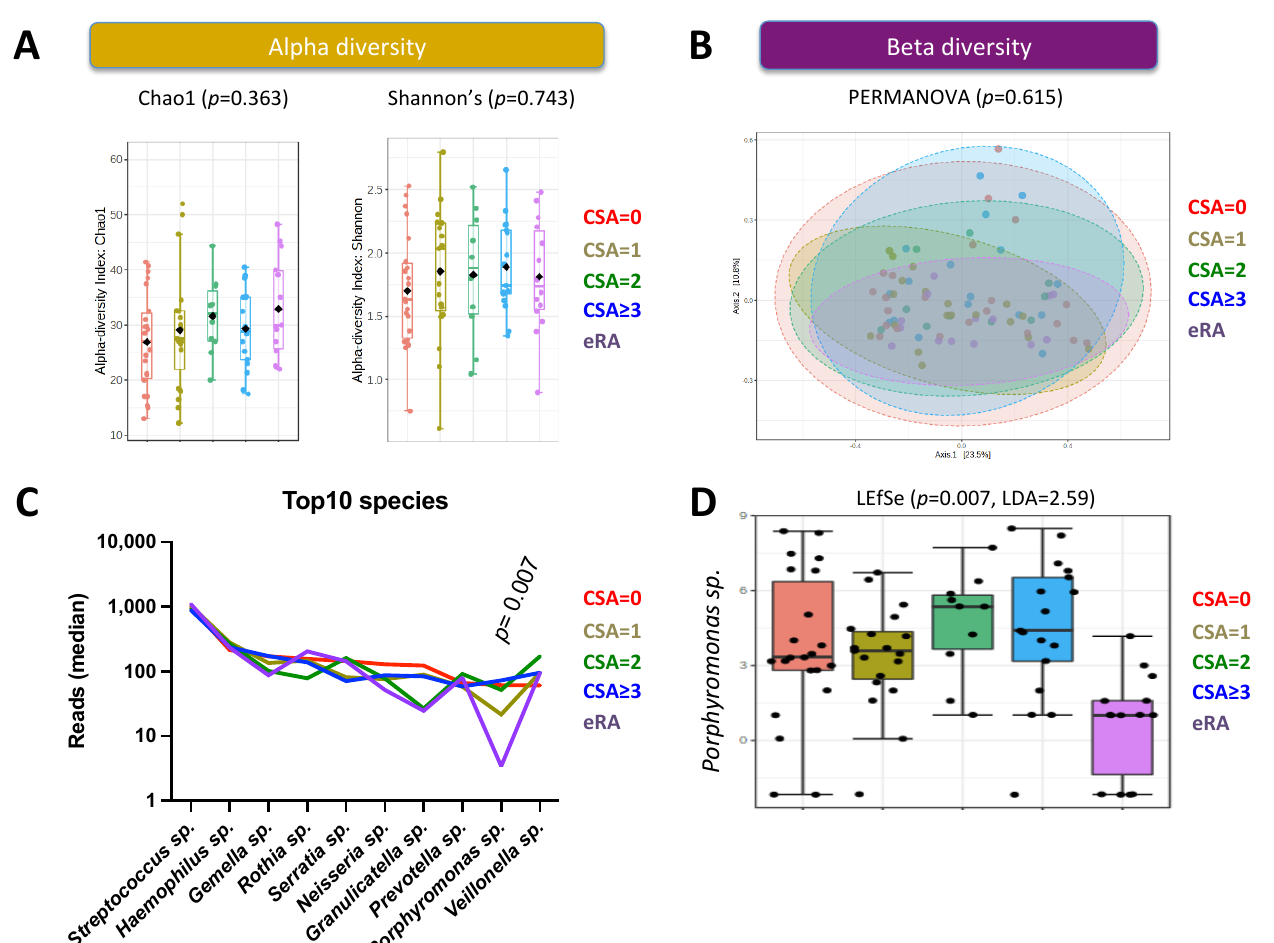
Figure 1. Alpha diversity, beta diversity and the oral abundance at the genus level in 15 patients with early rheumatoid arthritis (eRA), and 69 controls subdivided according to their clinically suspect arthralgia (CSA) score. ( A ) Alpha diversity as tested by Chao1 index and Shannon’s index. ( B ) Beta diversity tested by PERMANOVA (permutational multivariate analysis of variance); the percentage of variation explained by the principal component analysis (PCA) is indicated on the axes. ( C ) Top 10 genera with highest relative abundance in the 5 subgroups tested; ( D ) Box plots showing the relative abundance of the genus Porphyromonas sp. in controls and eRA. p values are based on Linear discriminant analysis (LDA) effect Size